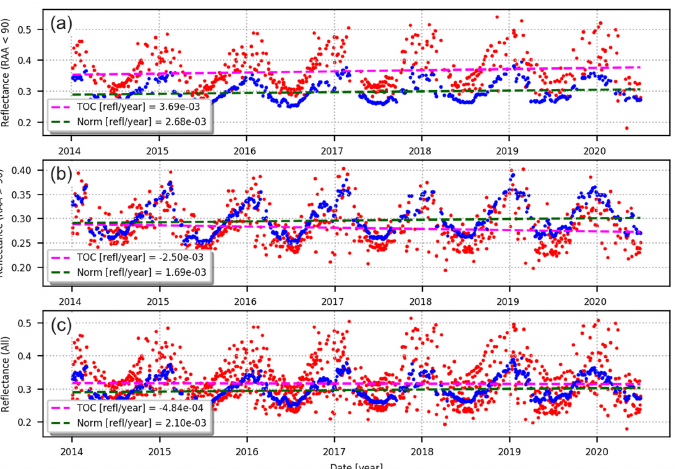
Figure 7. The figure shows TOC NIR reflectances over Belmanip-38 site in the Amazon rainforest (lat/lon = − 9.75°/ − 60.33°). The plots present the temporal series of TOC (red) and BRDF-normalized (blue) reflectances for three angular conditions: ( a ): RAA < 90°, ( b ) RAA > 90°, ( c ): “All”; the latter corresponds to retaining all observations in the fit. The fitted linear curves are also shown for TOC (purple) and BRDF-normalized (green) data with drift values reported in the legend. The temporal series over a cropland site, Barrax in Spain (lat/lon = 39.06°/ − 2.07°), is presented in Figure 8. The evolution of TOC NIR reflectances is more complex over this